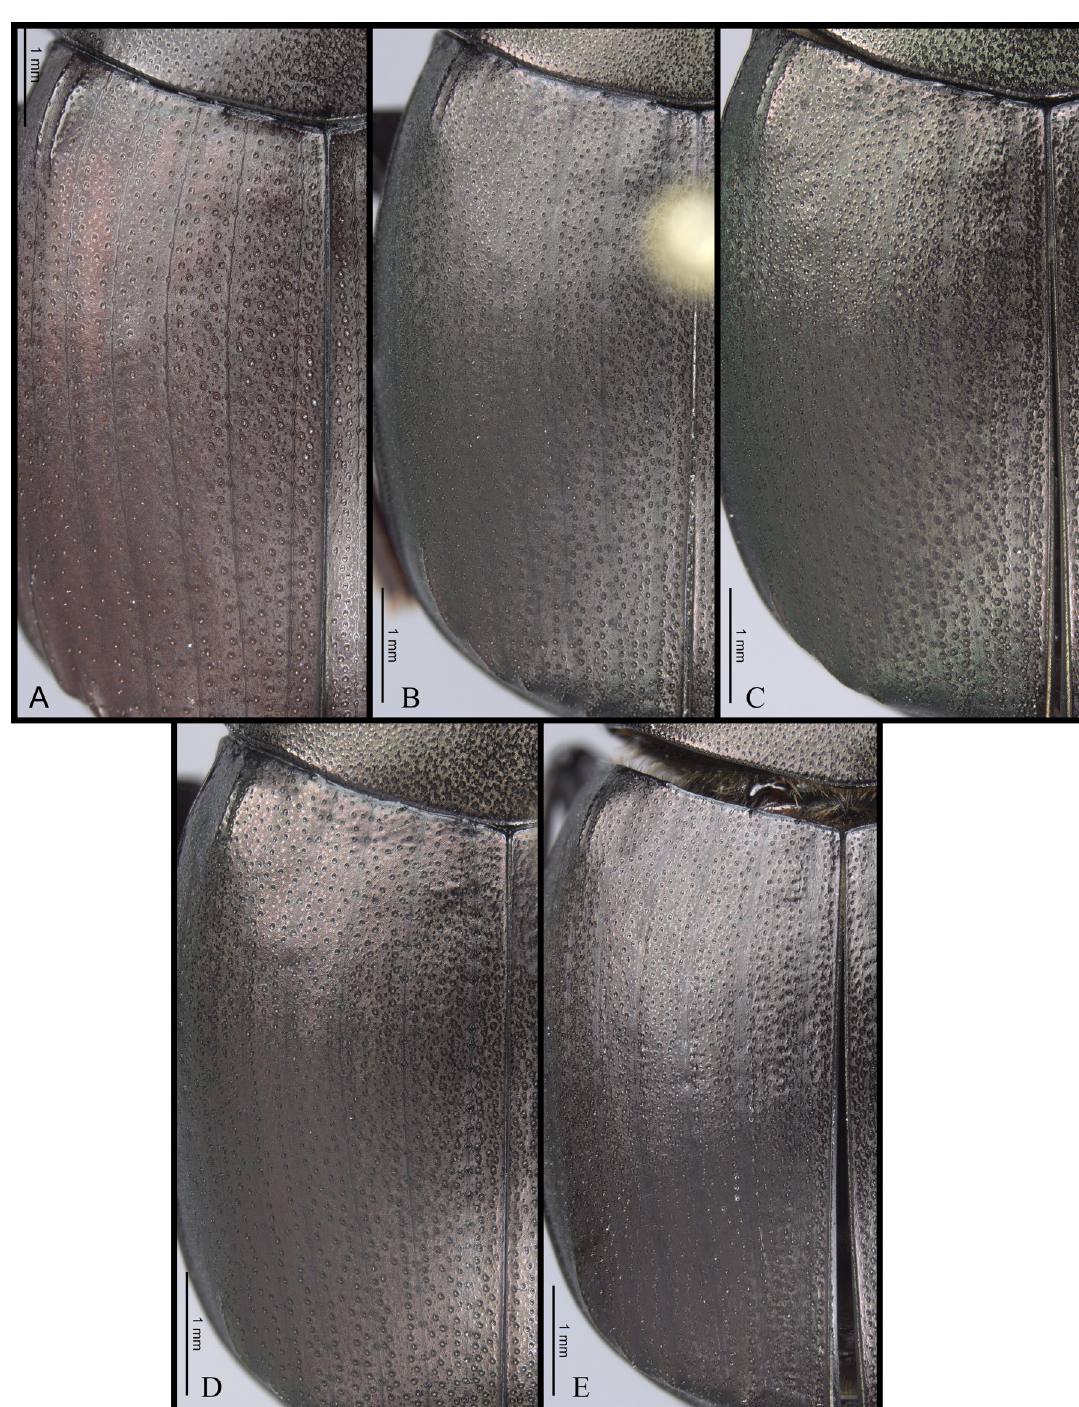
Fig. 4. Elytra of members of the gilli species group. A . Holotype of Deltochilum gilli González- Alvarado & Vaz-de-Mello, 2021, CNCI 379888. B . Holotype of D. jocelynae sp. nov., CNCI 379889. C . Holotype of D . nonstriatum sp. nov., CMNEN WSD00041746. D . Holotype of D . quasistriatum sp. nov., CMNEN WSD00041744. E . Holotype of D . tenuistriatum sp. nov., CMNEN